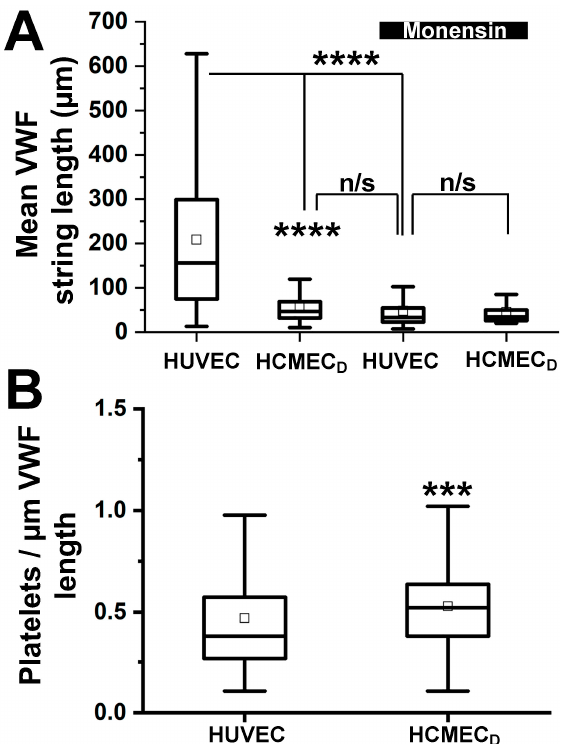
Figure 8. VWFs secreted from HCMEC D form shorter extracellular strings but capture platelets efficiently. ( A ) Whisker plots (25–75% range, inner box; mean, error bars; range 1.5IQR, horizontal bar; median) of the lengths of extracellular strings of VWF produced following histamine-evoked WPB exocytosis in control HUVEC (n = 868 strings from 24 fields of view, 3 independent experiments) or HCMEC D (n = 750 strings from 35 fields of view, 5 separate donors). String lengths after treatment with 10 µ M monensin for 2 h: HUVEC; n = 741 strings from 25 fields of view, 2 independent experiments, HCMEC D ; n = 677 strings from 24 fields of view, 3 separate donors. Olympus IX71 equipped with 20 × 0.4NA Ph1 objective, see Section 4.5. ( B ) Number of platelets bound per 1 µ m length of VWF secreted from HUVEC (n = 139 strings, 12 fields of view, 3 separate experiments) or HCMEC D (n = 154 strings, 16 fields of view, 3 separate donors). Olympus IX71 equipped with 40 × 0.4NA Ph2 objective). ( A ) ****; p < 0.0001, one-way ANOVA, GraphPad Prism. ( B ) ***; p = 0.003, t -test, GraphPad Prism. n/s; no significant difference. WPB; Weibel–Palade body. VWF;